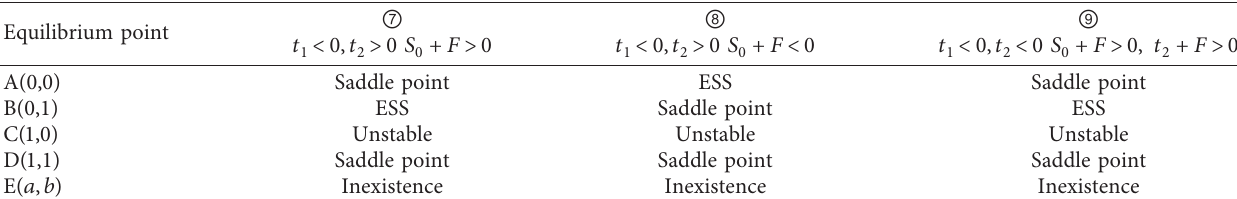
Table 9: Local stability of each equilibrium point in the range of different parameter values.